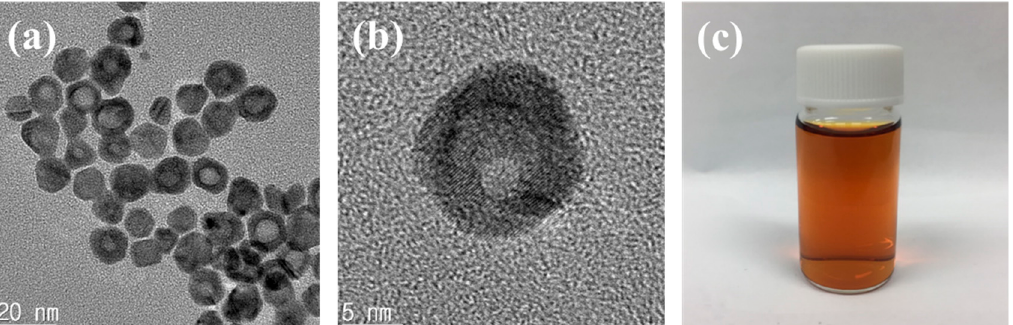
Figure 2. TEM image ( a ) and HR-TEM image ( b ) of hollow Ag-Au nanostructures and ( c ) digital photograph of resultant solution of hollow Ag-Au nanostructures.